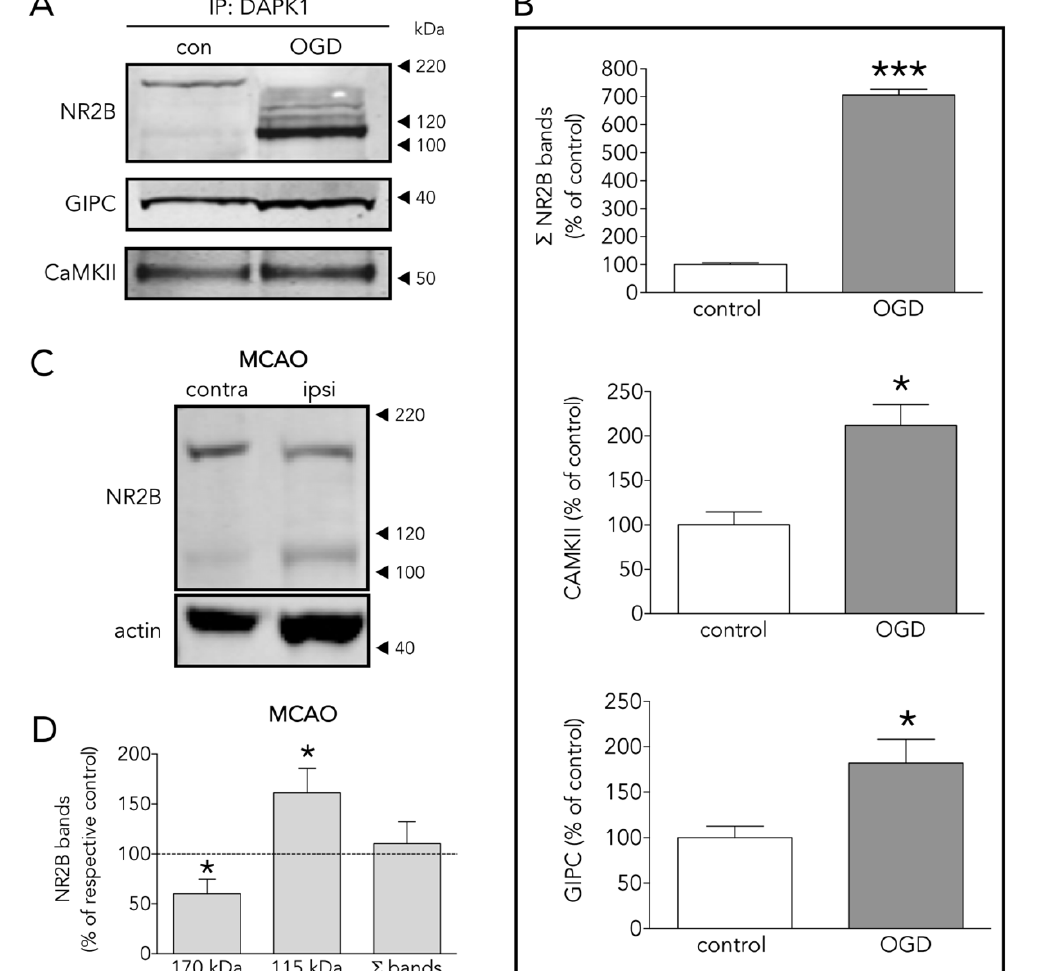
Figure 4. Several DAPK1 interactors are CTD-NR2B binding partners. ( A ) WB and ( B ) quantification of the effect of OGD on the co-immunoprecipitation of DAPK1 with the well-known DAPK1 interactors NR2B, CAMKII and GIPC ( t test, n = 4–5 co-immunoprecipitations from independent primary neuron culture preparations). ( C ) WB showing the effect of MCAO on the NR2B band levels. ( D ) Effect of MCAO on 170 kDa, 115 kDa and total NR2B levels (paired t test, n = 9 rats, comparing ipsilateral (ipsi, ischemic) brain hemisphere with the contralateral (contra, control) one). The results are shown as the mean and SEM. * p < 0.05, *** p < 0.005 vs. respective control in all graphs.